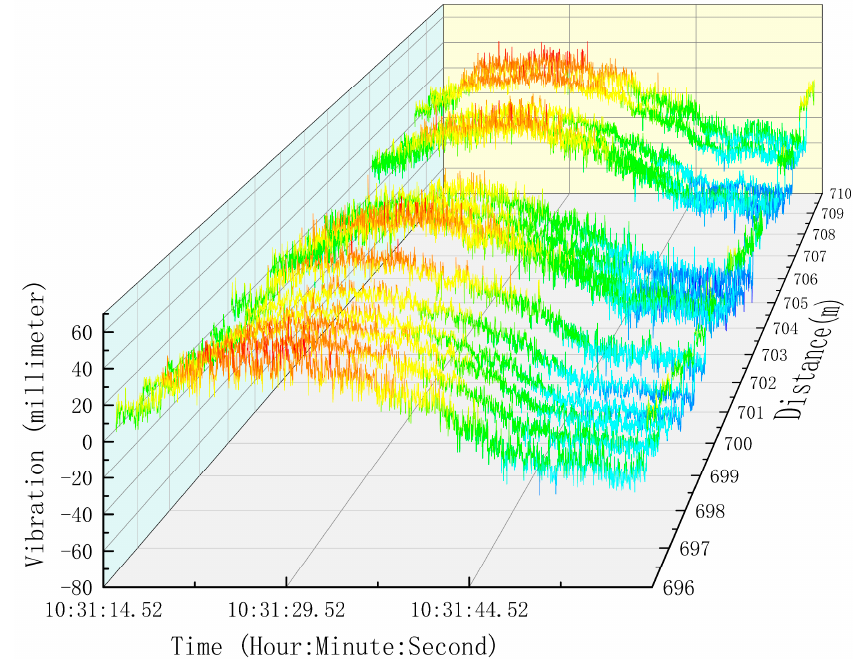
Figure 9. The vibration of the 15 pixels acquired by the GBSAR.